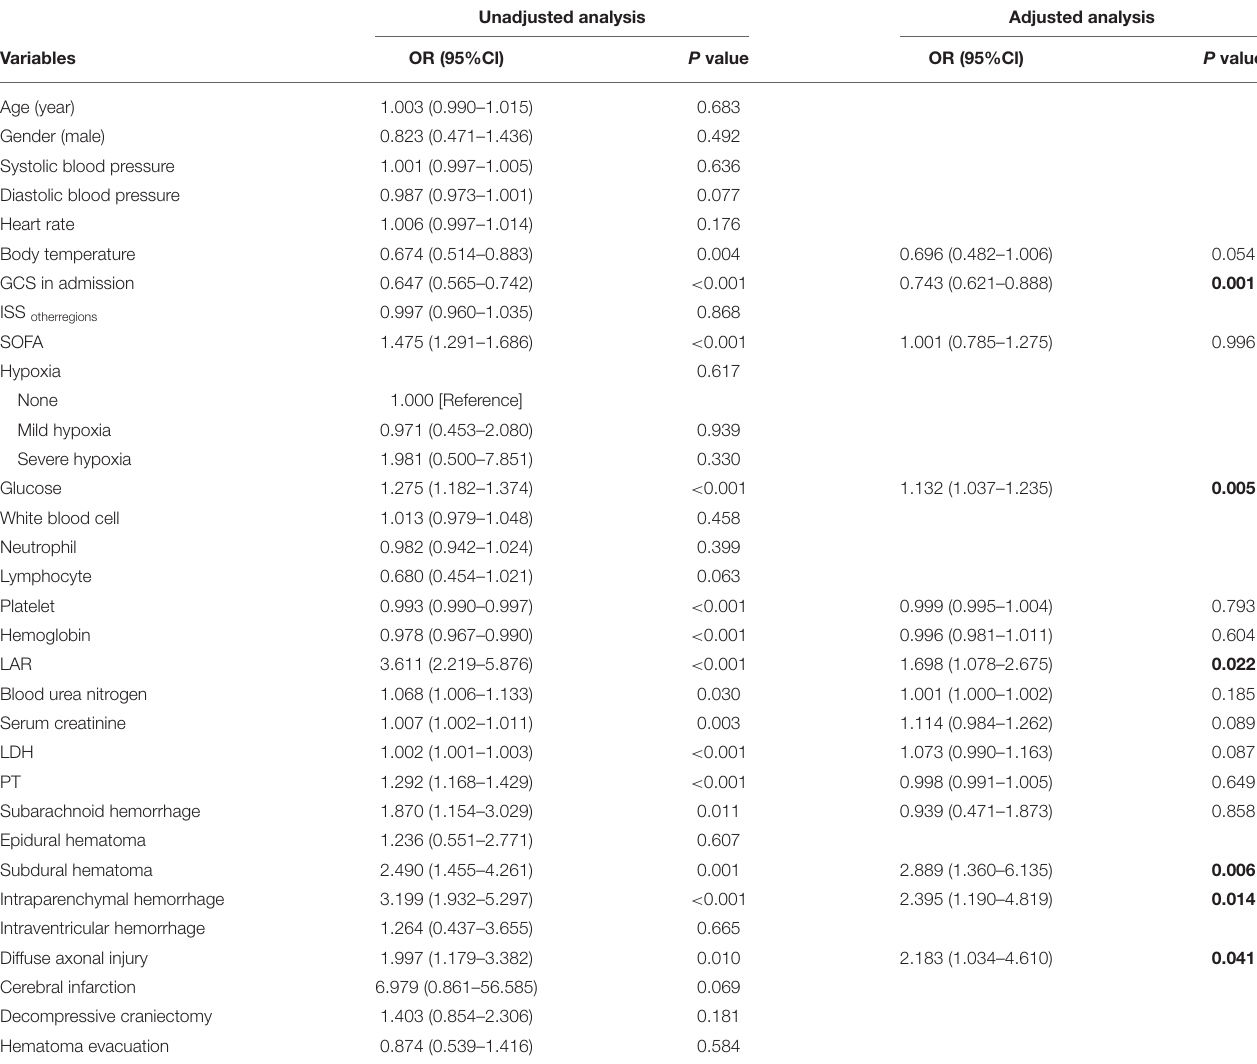
TABLE 3 | Univariate and multivariate logistic regression analysis of risk factors for mortality in patients with moderate to severe TBI. Unadjusted analysis Adjusted